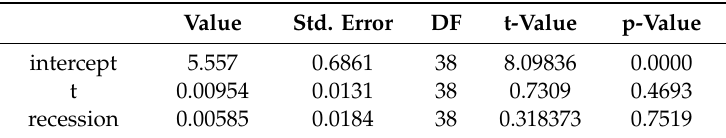
Table 3. Results of linear mixed-e ff ect Model